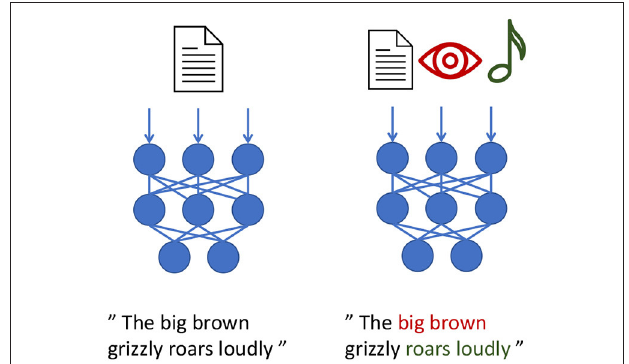
FIGURE 2 | We illustrate an example using a neural text-processing model that integrates text only (left) and text in combination with vision and sound (right) . Possible associations or groundings are